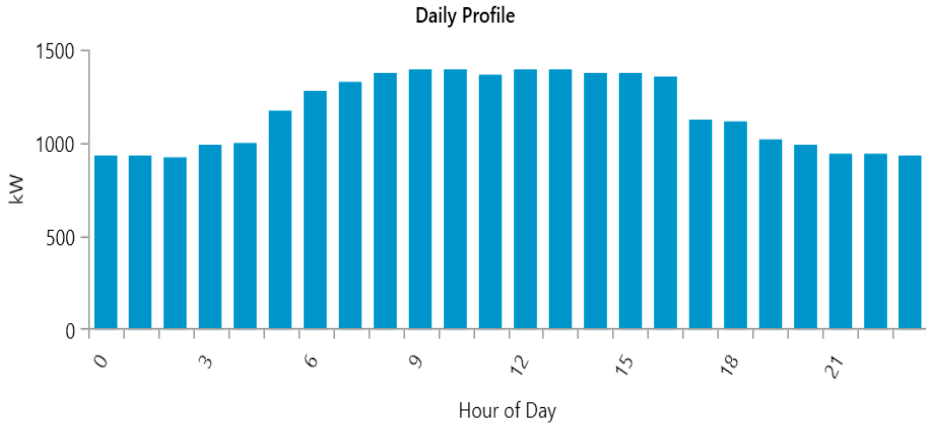
Figure 3. Daily load profile for the hospital (Mandalika).